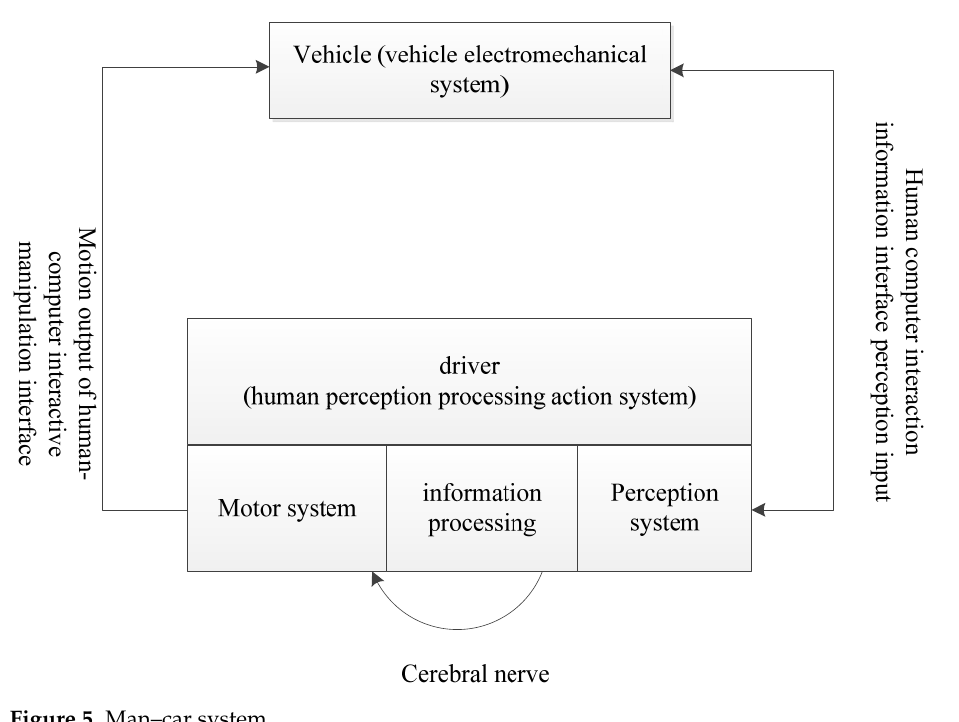
Figure 5. Man–car